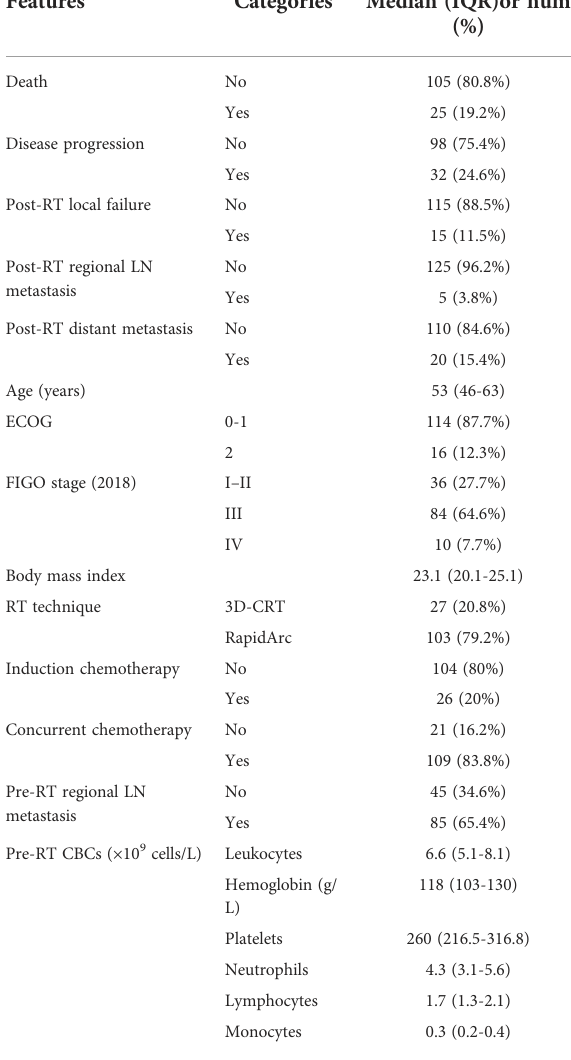
TABLE 1 Baseline characteristics and clinical outcomes of the